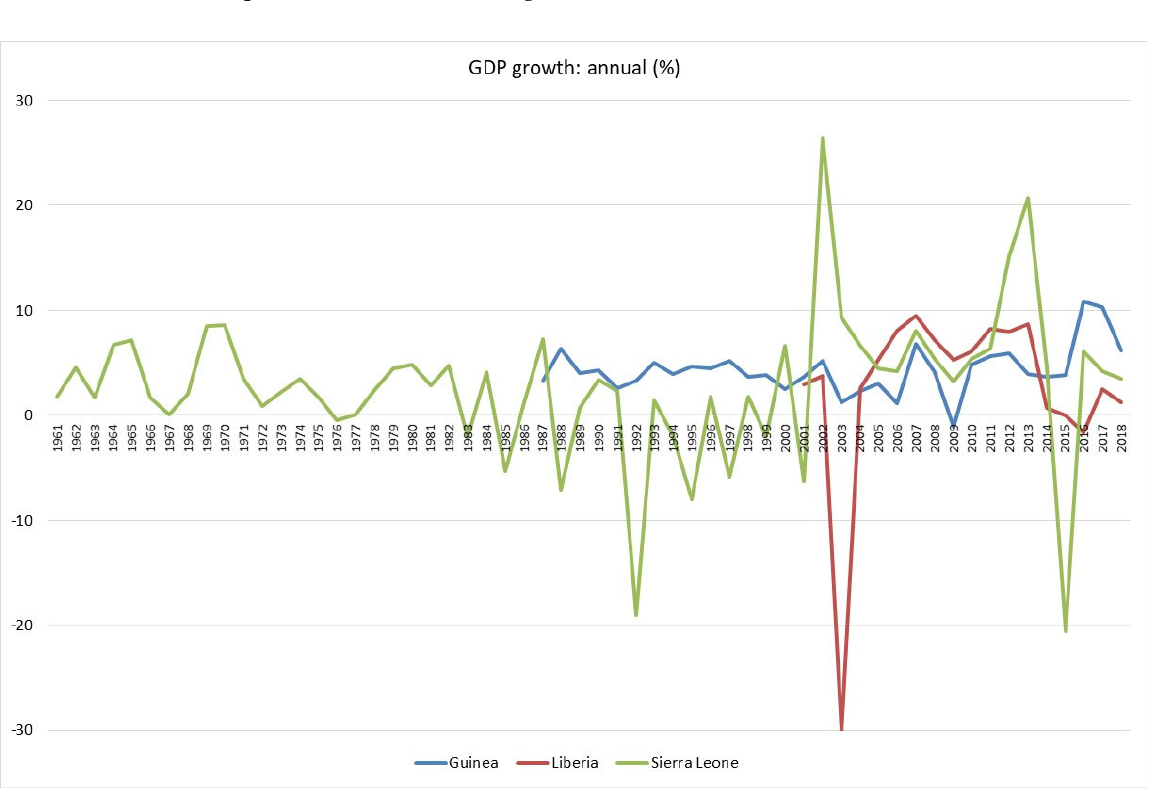
Figure 3. Time series of GDP growth. Source: World Bank, World Development Indicators.